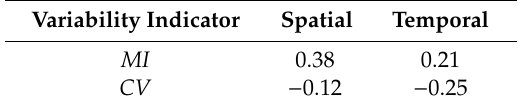
Figure 4. Relationship between rainfall variability and rainfall nowcasting correlation skill. Table 2. Correlation coefficients between rainfall variability and rainfall nowcasting correlation skill.